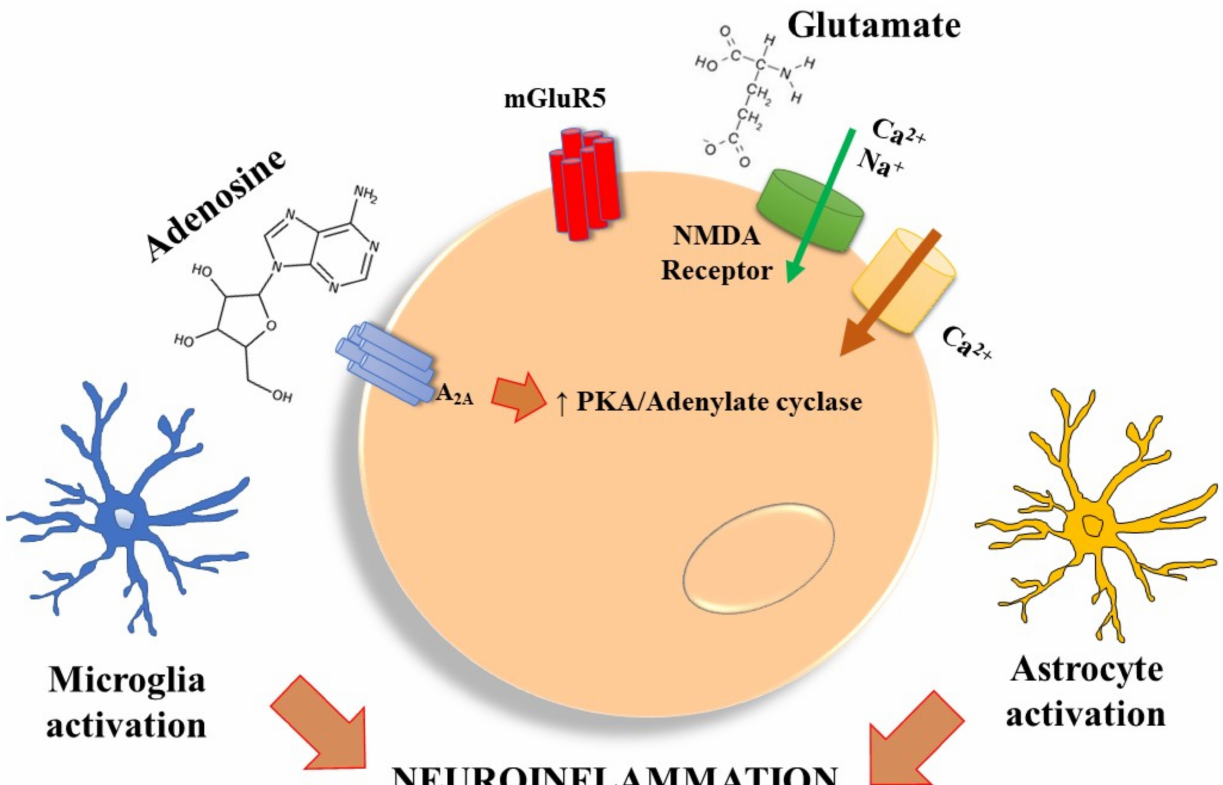
Figure 1. The picture represents the physiological effect of A 2A receptor activation on post-synaptic neurons, microglia, and astrocytes. In more detail, its post-synaptic stimulation leads to mGluR 5 activation and NMDA phosphorylation thus increasing calcium influx, while in microglia and astrocytes it raises activation and proliferation with an increase in